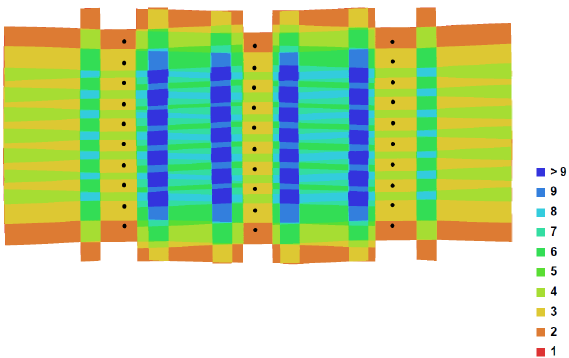
Figure 2: overlap-analysis of the test-area Khartoum A key-issue was the processing of the data without any stitching of the triplet before. Processing the single images in standard AT software creates problems for the mathematical models to solve identical projection centers with very different projection angles. Even the offset-angles are known, it can cause limits in detecting suitable tie-points. Using some actual software tools, designed for UAVs, a first alignment was successfully solved (e.g. Photoscan) and the results transferred then to other adjustment softwares (e.g. Bingo). To map the railway-corridor from Khartoum to Port Sudan the calibration was important in order to reduce the number of GCPs in the desert area. Using AeroDiDOS GNSS-IMU, a robust mounting of the cameras and a completely by the IMU controlled stabilized mount became part of the setup. A test- field near Khartoum was used for a calibration flight to determine the borside angles. With an error of better than 0.5 pixels, the system was that way prepared for the final